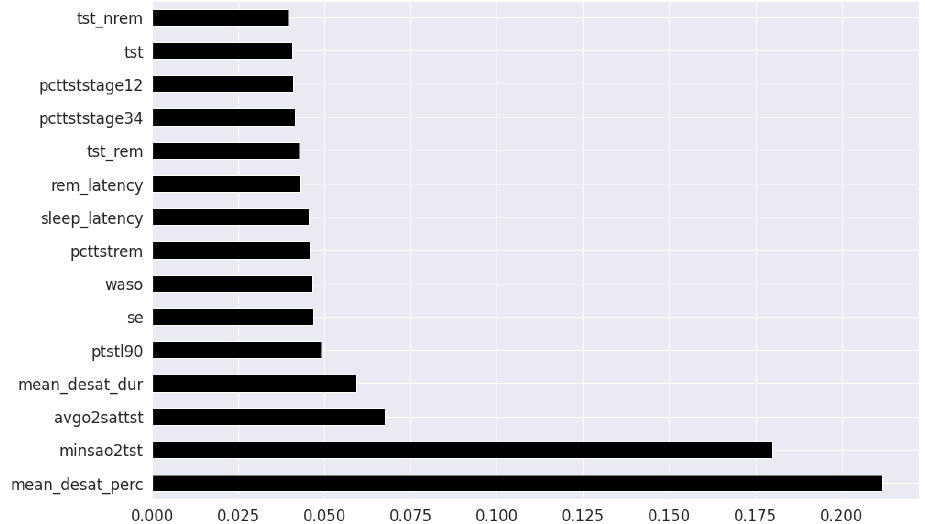
Figure 7. PSG features ordered as per Extremely Randomized Trees.